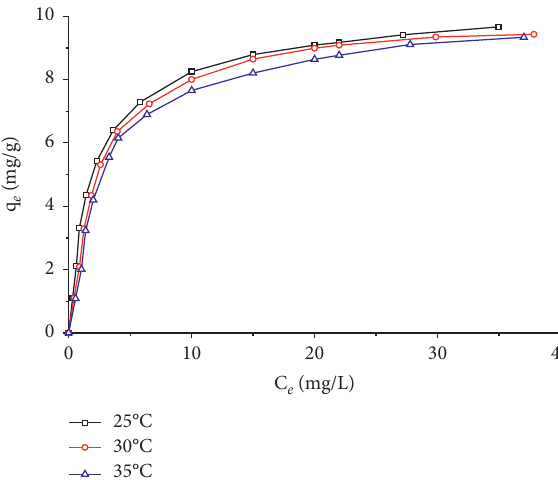
Figure 8: Response surface plot for Cr(VI) removal using orga- nobentonite. Conditions: C i � 50mg/L, V � 50mL, T � 20 ° C, stir- ring speed � 230rpm, and contact time � 150min. Table 4: Points for the validation of the experimental design. Adsorbent amount